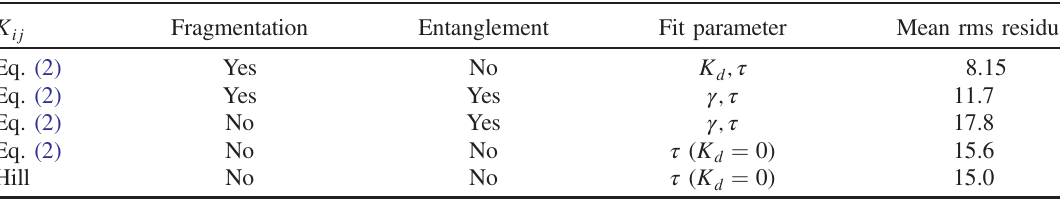
TABLE I. Mean rms residual, averaged over the three experimental repeats, for the fits to the experimental data using different models. Column 1: K used [our model, Eq. (2) or Hill model]. Column 2: fragmentation (yes or no). ij 0 . Column 3: entanglement (yes or no). No entanglement corresponds to No fragmentation corresponds to K d ¼ γ ¼ 0 . Column 4: parameters used for the fit. Column 5: rms residual from the fit averaged over the three experimental repeats. For more details on the fitting procedure, see Appendix